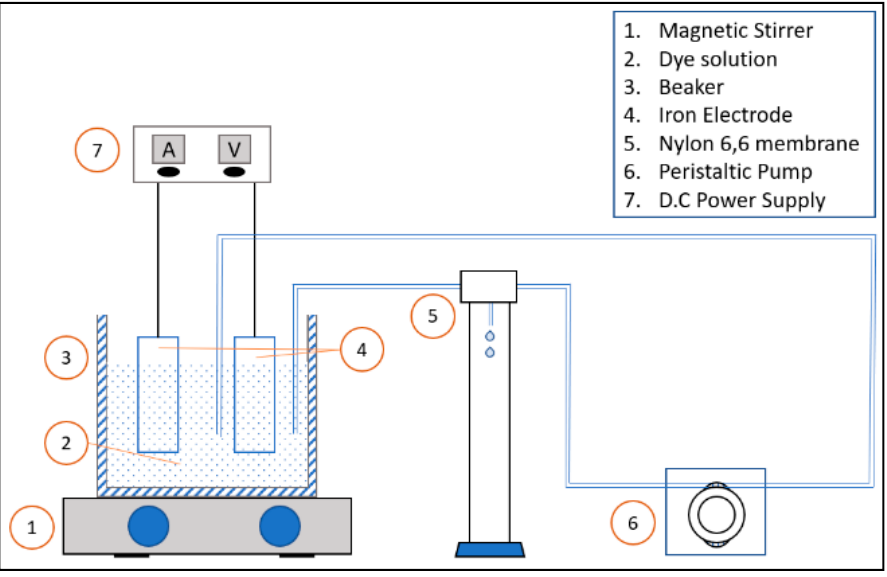
Figure 1. Schematic of the integrated system with the membrane as the post-treatment.